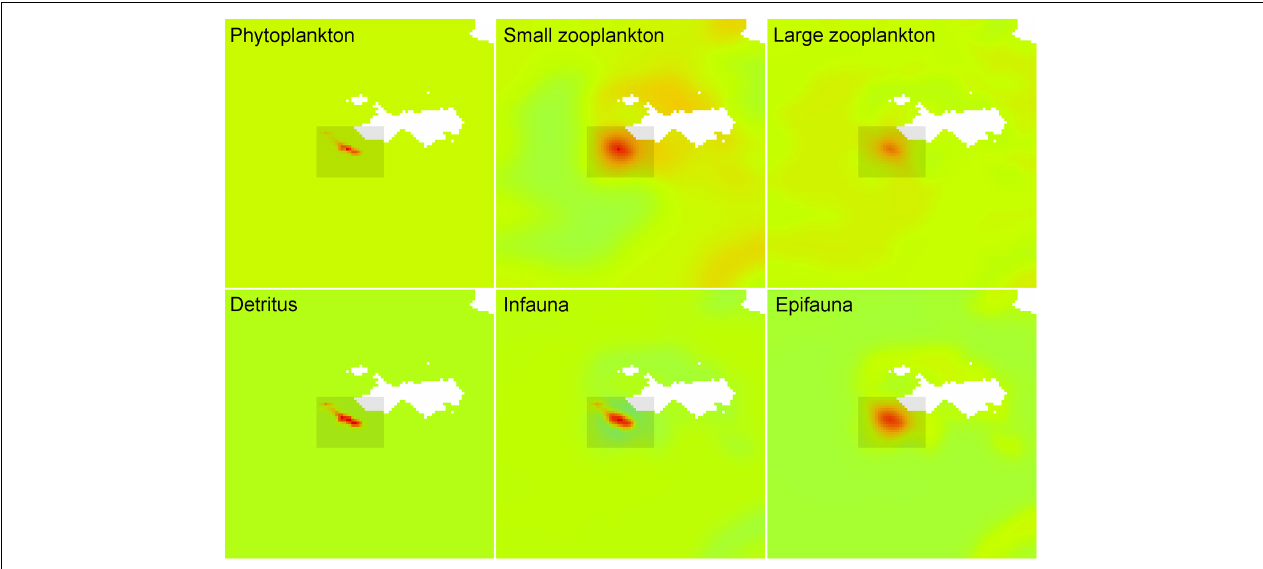
FIGURE 6 | Species relative biomasses extracted at the end of the scenario 6 simulation (2013) showing the relative foot-print increases of phytoplankton, small zooplankton, large zooplankton, and detritus, infauna and